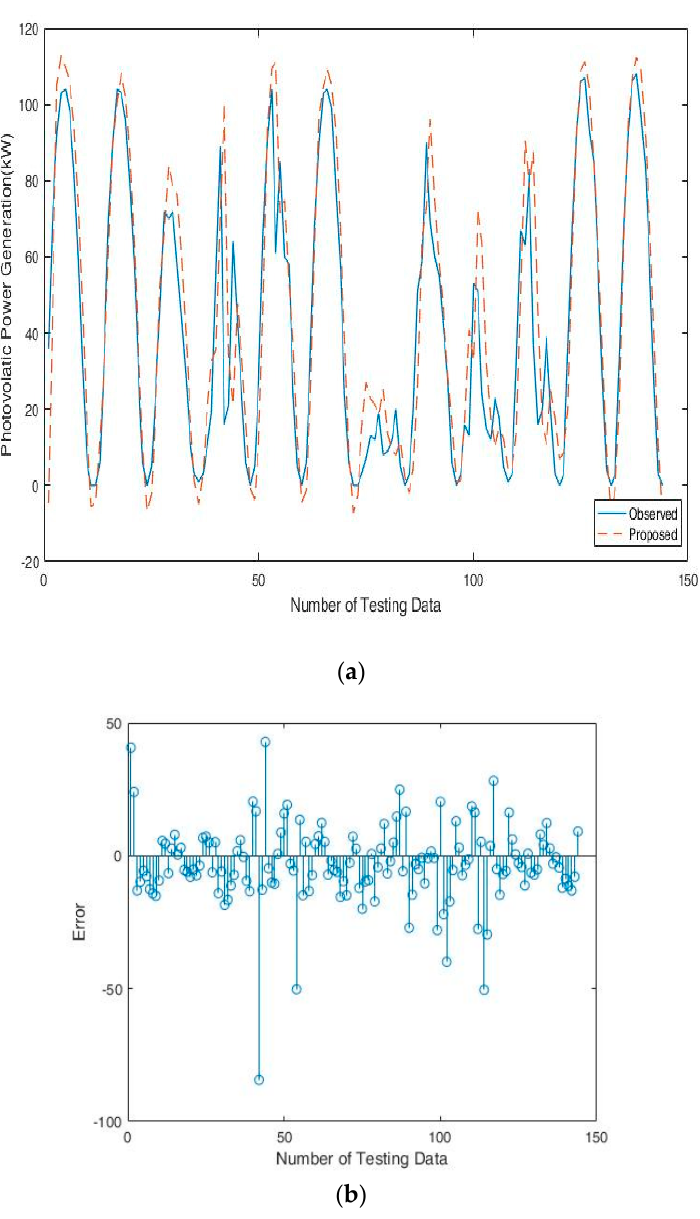
Figure 5. Wind power prediction of the modified long short-term memory (LSTM): ( a ) Comparison of observed values with predicted values using LSTM; ( b ) Predicted error for observed values and predicted values.